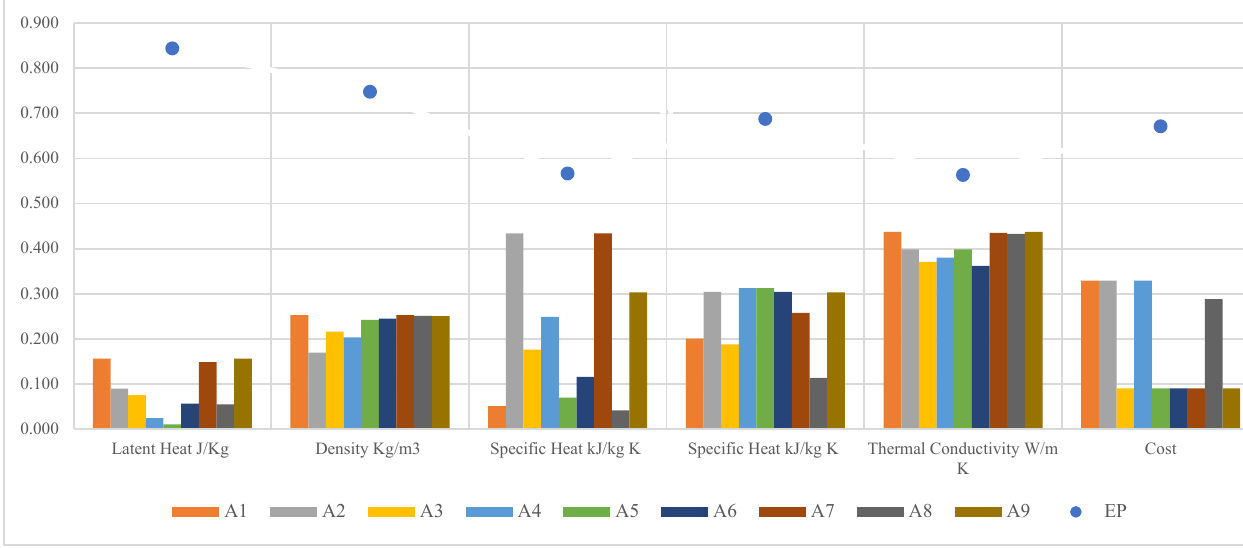
Figure 3. The distance between EP and the data set of each material.